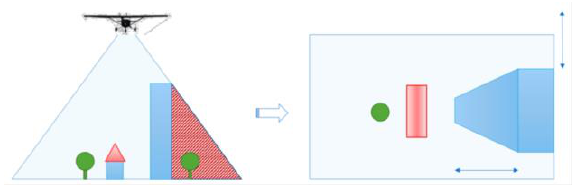
Figure 3. TrueDOP: a) PAN- without postprocessing b) PAN-with interpolation c) PAN-with antialiasing d) RGBI-with interpolation e) RGBI-with antialiasing Figure 2. Tilting effects in classic DOP (Source: Wenzel, nFrames GmbH)